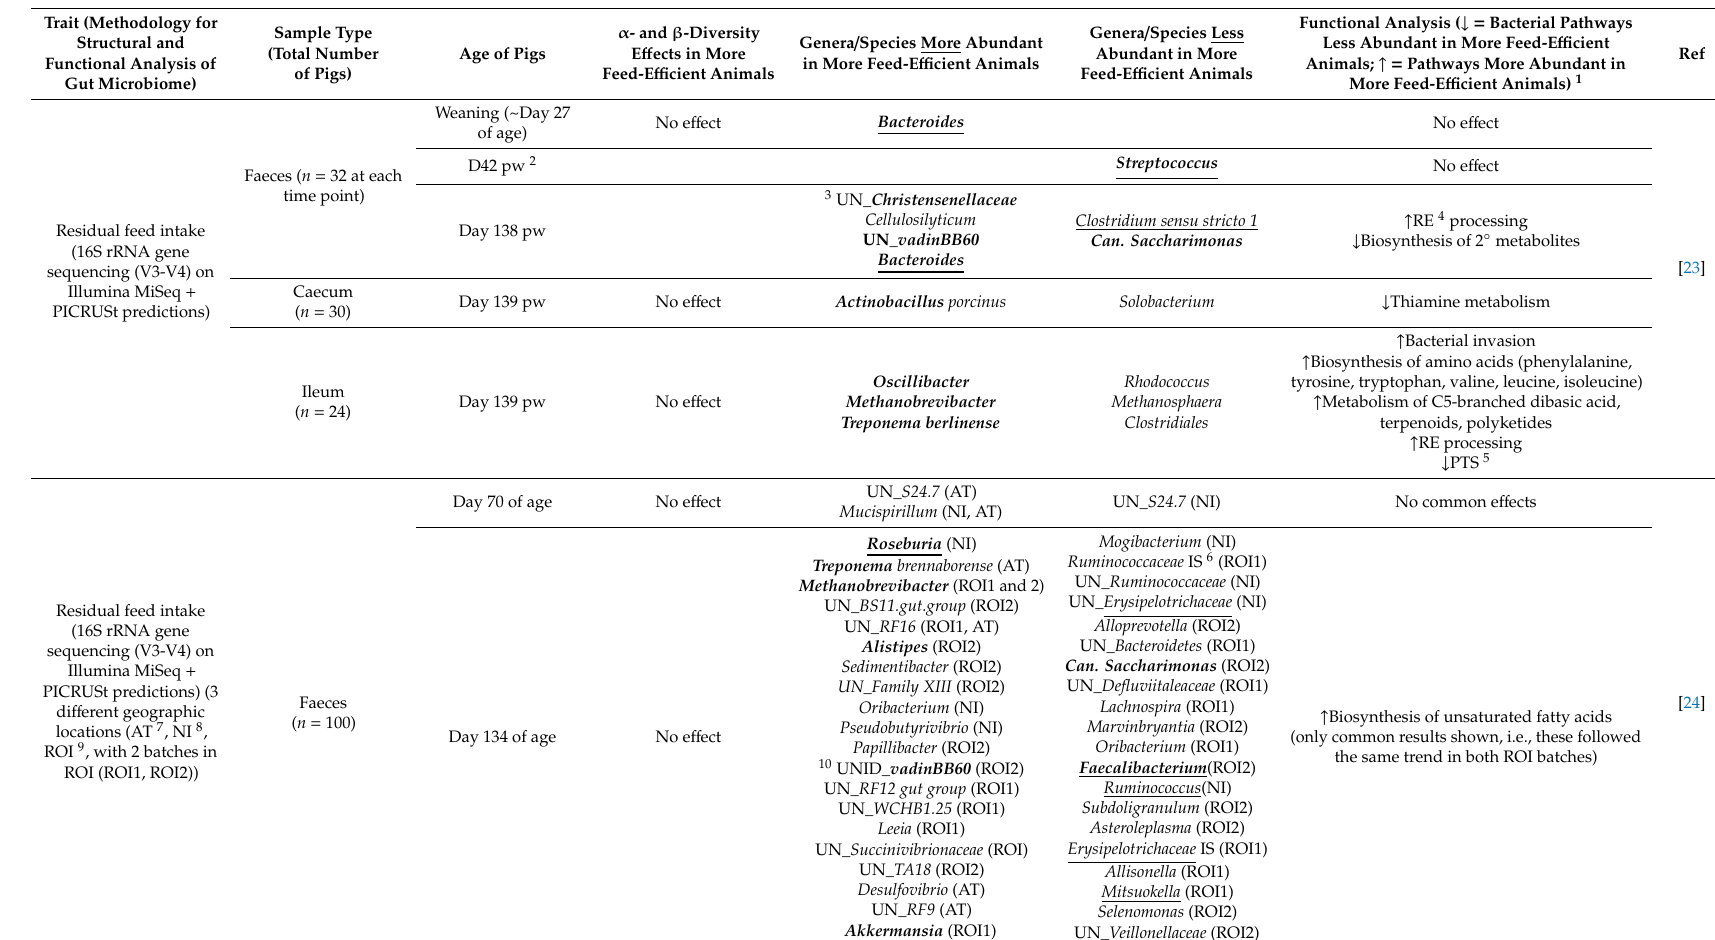
Table 2. Bacterial diversity within the gut microbiome of pigs ranked on feed e ffi ciency and bacterial genera / species and related pathways / genes 1 linked with feed e ffi